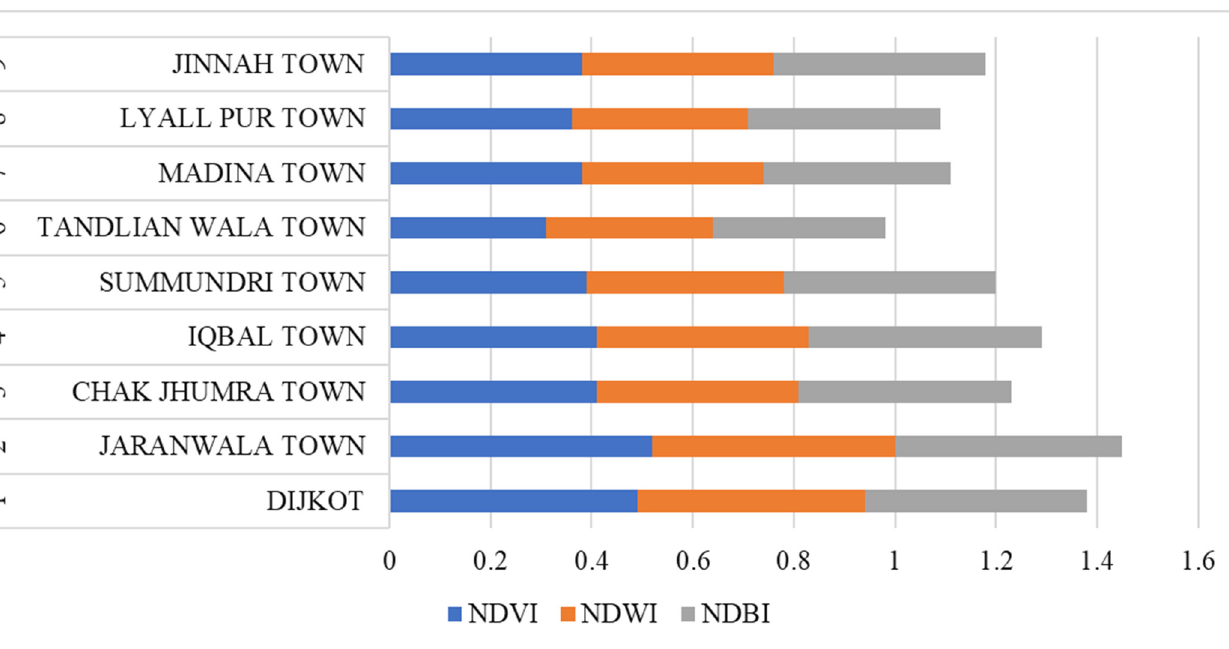
Figure 7. Relative ranked mean of the Indices.